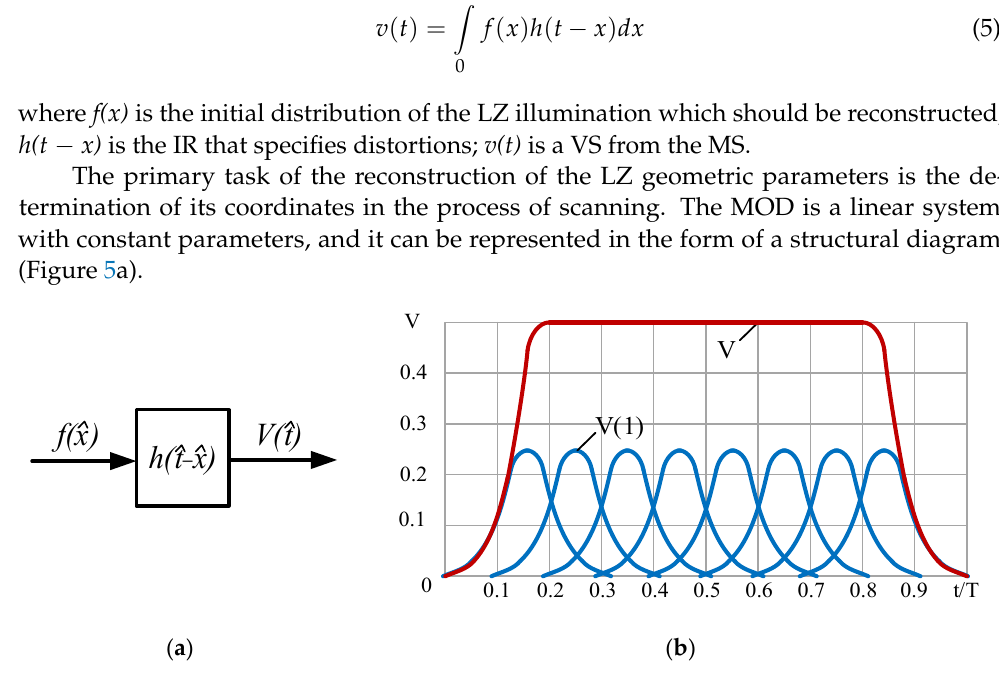
Figure 5. The mechanism of the multiscan video-signal formation: ( a ) the scheme of the convolution of the impulse response and light zone parameters; ( b ) the sum video signal V of the multiscan and the elementary video signals V(1) of its photodiode cells.